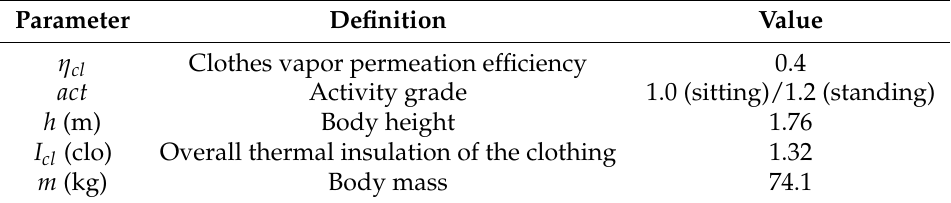
Table 9. Parameters of the test subjects for the computation of the thermal comfort.